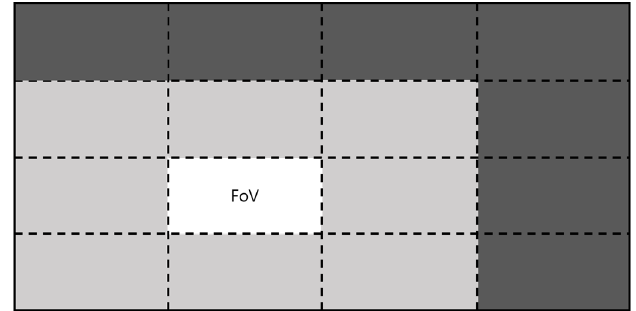
Figure 1. User screen for FoV.